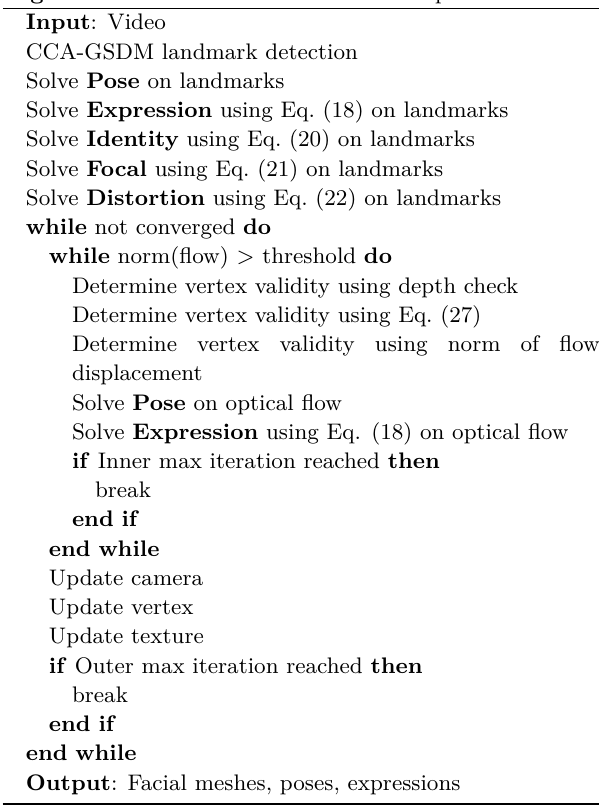
Algorithm 1 : Automatic dense facial